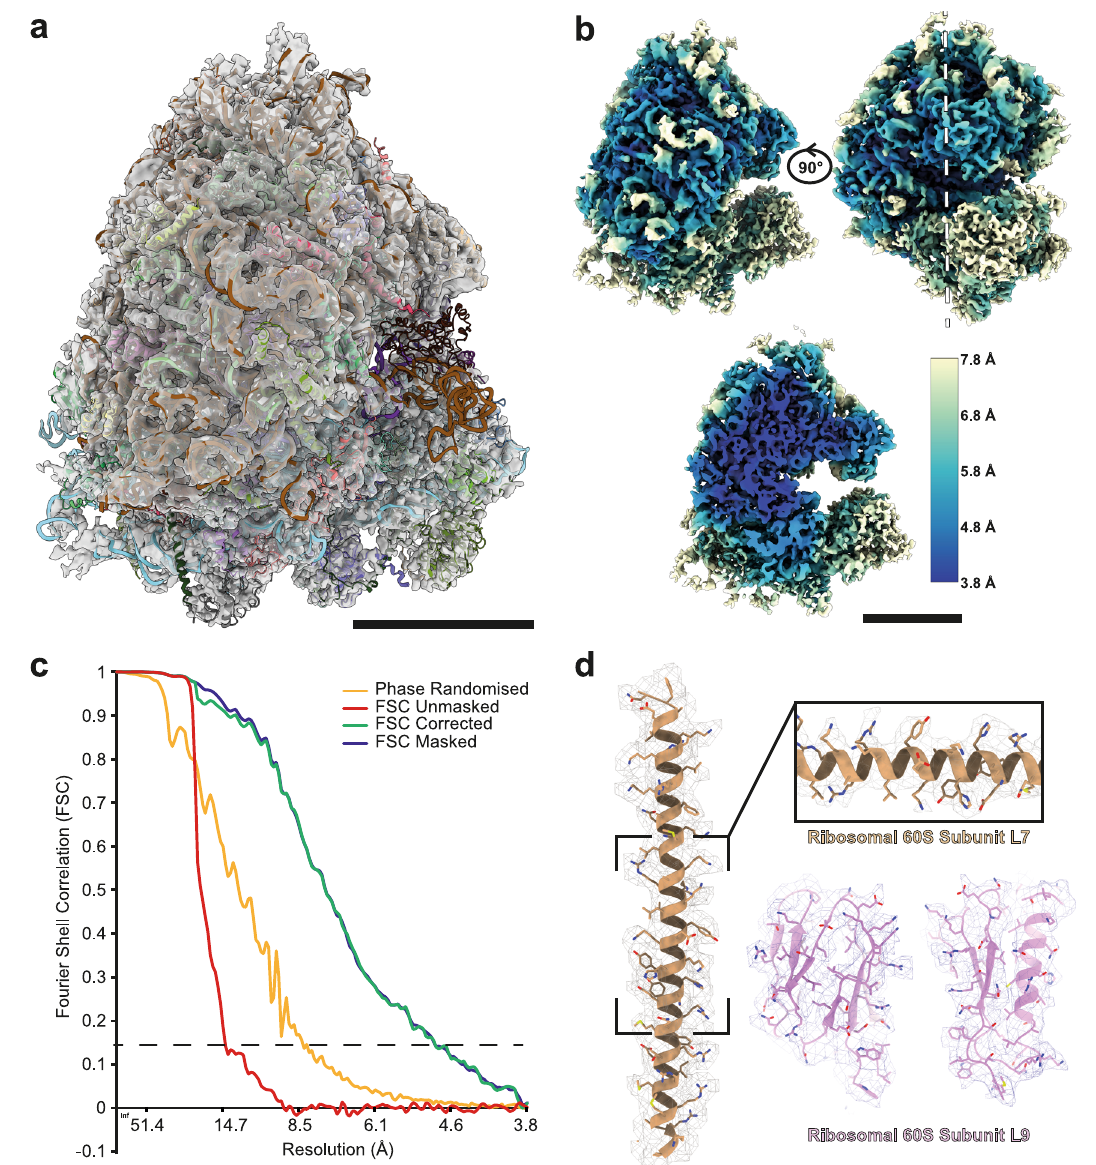
Fig. 3 | Structure of the human 80S ribosome obtained from cellular tomo- grams. a Density map of the 80S ribosome with fi tted single-particle determined model of the human ribosome obtained from isolated ribosomes (PDB: 4UG0 53 ) scale bar: 10nm. b The same density map colour-coded for the local resolution from the outside (top) and a central slice (bottom, white line) (scale bar: 10nm).